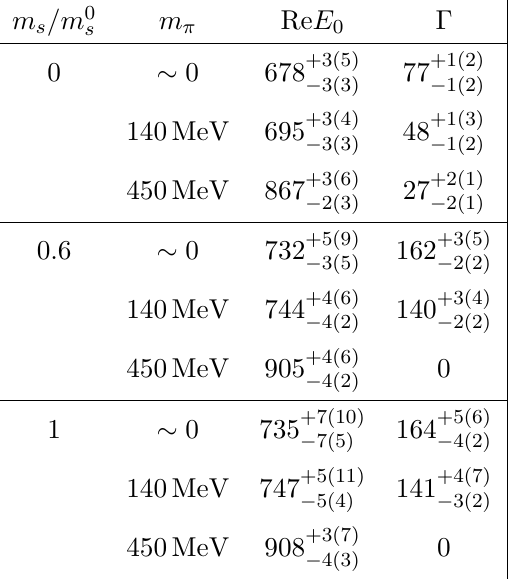
Table 11 . (cid:26) (770) meson mass, Re E 0 , and width, (cid:0) = (cid:0) 2Im E 0 , extracted from the pole position for several strange-quark masses at the chiral limit, physical pion mass and m (cid:25) ’ 450, i.e., when it becomes a bound states in the m s = 0 ; 1 m 0 trajectories. The central value represents the median, s the (cid:12)rst upper and down indices gives the 68% CI, while the sum of the absolute values of the two upper (down) indices provides the upper (down) limits of the 95%